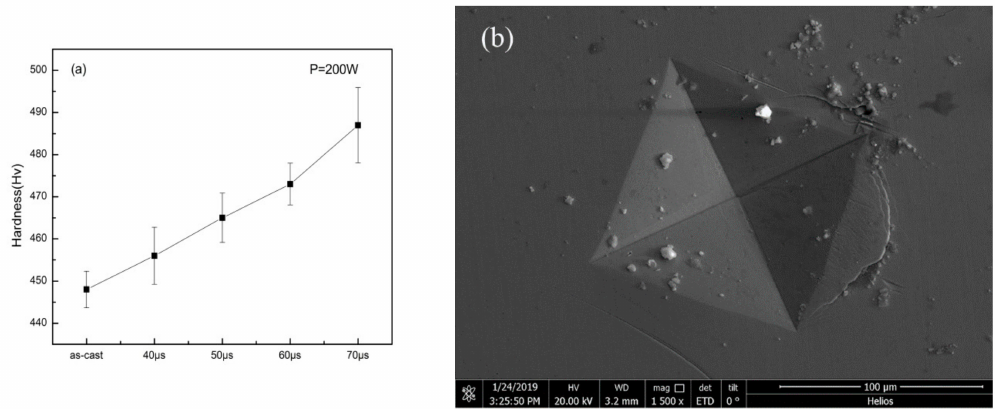
Figure 10. ( a ) Vickers hardness results of as-cast specimen and specimens with di ff erent exposure times; ( b ) indentation on specimen with parameters of P = 200 W, t = 40 µ